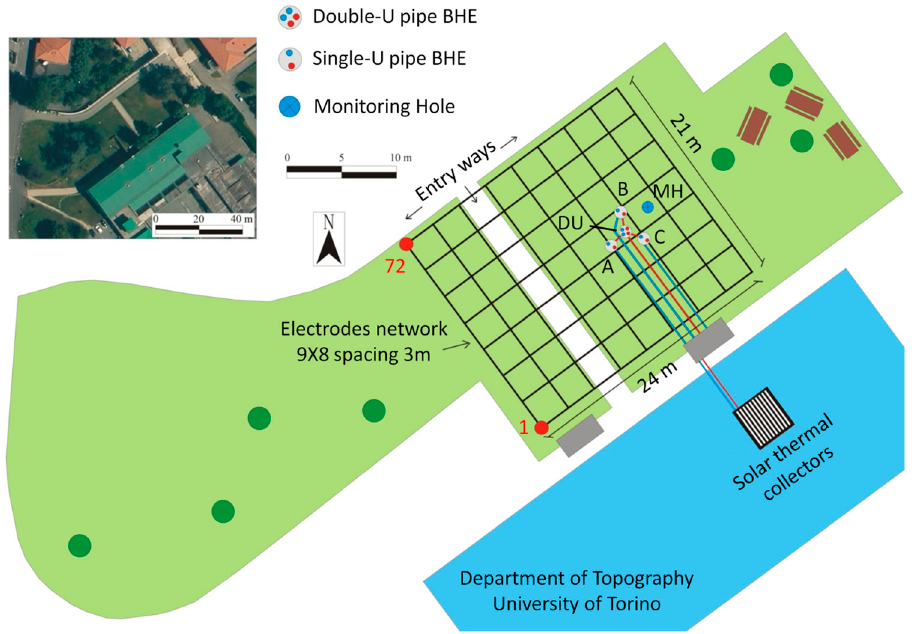
Figure 1. Borehole thermal energy storage (BTES) system in Grugliasco with the disposition of the electrodes for the time-lapse 3D electrical resistivity tomography (ERT) acquisitions and plant connection; red pipes are inflow; blue pipes are outflow.